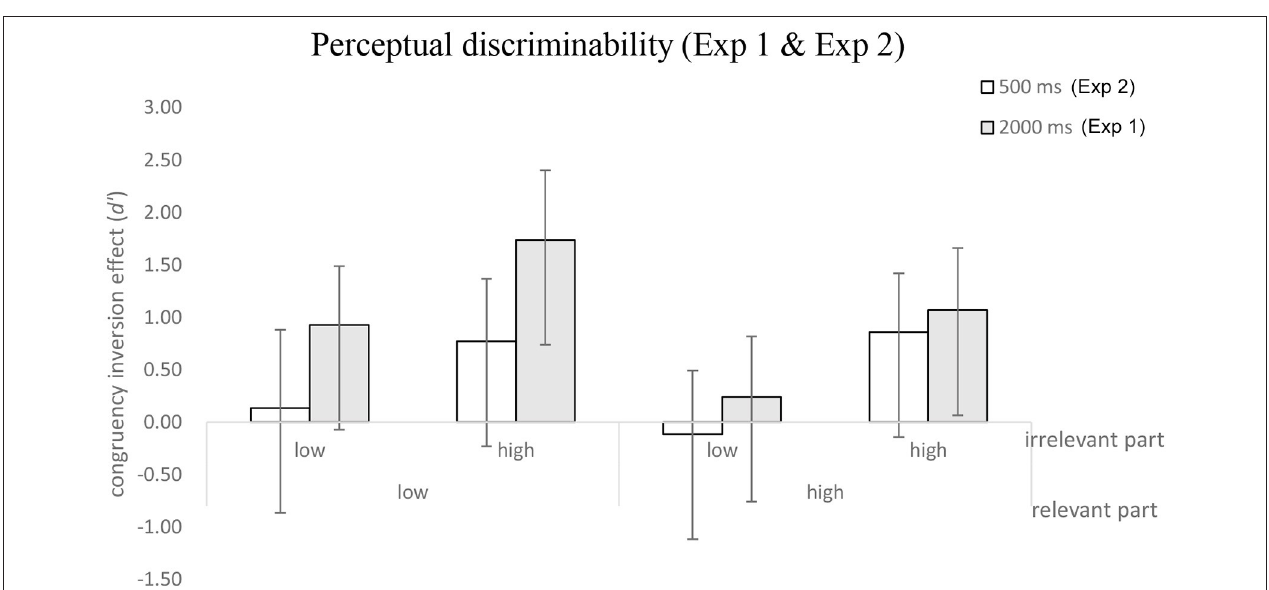
FIGURE 7 | The mean of the congruency inversion effect ( d ’) as a function of spatial distance and perceptual discriminability of the relevant and irrelevant parts in Experiment 2. The first two rows of the legend denote the perceptual discriminability of irrelevant parts (high vs. low), and the third row denotes spatial distance between the faces (near vs. far). Error bars indicate 95% confidence interval, calculated within participants.